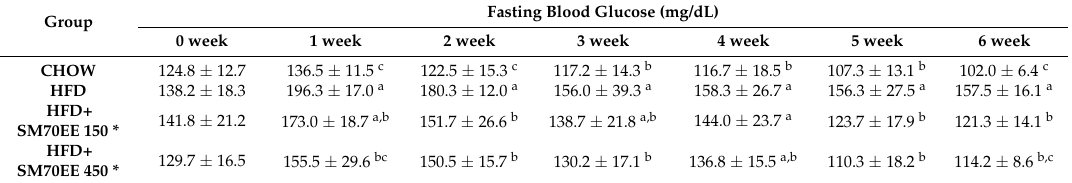
* (mg/kg/day), Data are expressed as mean ± SD ( n = 6). Values with different letters are significantly different, p < 0.05 (a > b > c). Table 5. Effect of SM70EE treatment on fasting blood glucose level in HFD-induced obese mice for 6 weeks. Group